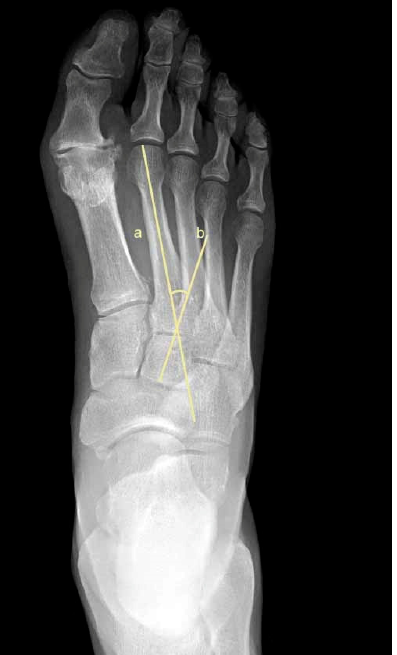
Figure 5. Dorsoplantar weightbearing radiograph of Engel’s angle.